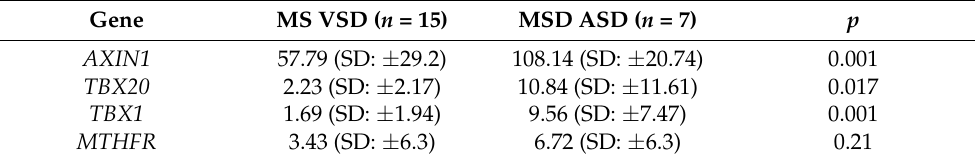
Table 4. Comparison of gene MS between ventricular septal defects and atrial septal defects. Gene